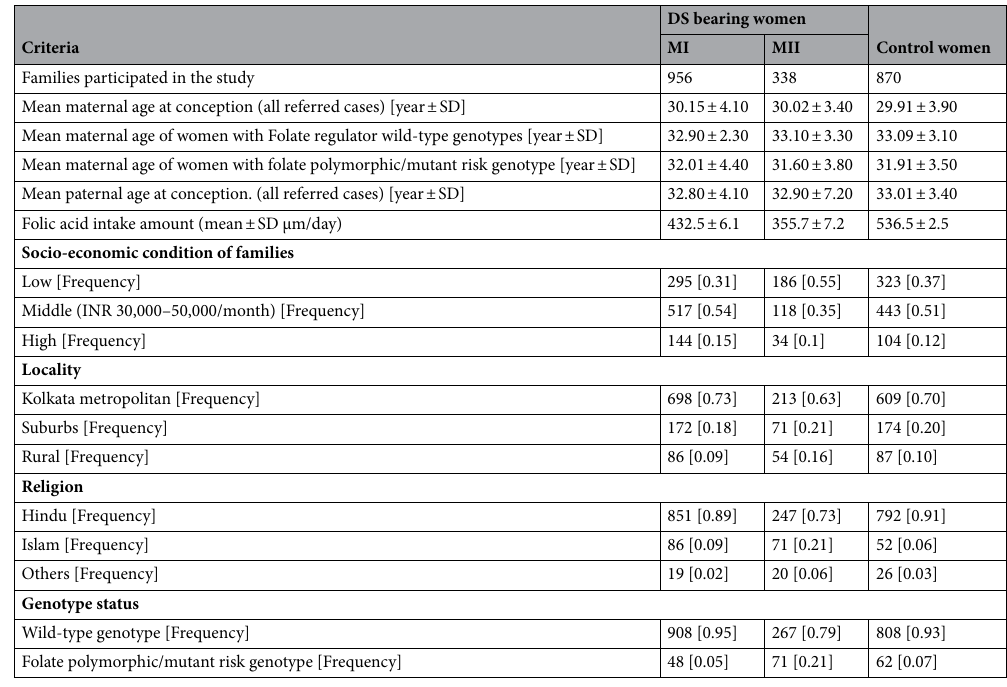
Table 1. Demographic and epidemiological detail of participating families in the study. DS Down syndrome, MI Meiosis I, MII Meiosis II, SD standard deviation. t-tests were used to test for differences between mean maternal and age at conception, preconception maternal folic acid intake amount, chi square ( χ 2 ) tests were used to compare other epidemiological parameters between MI and MII case and control groups. P value < 0.05 was considered statistically